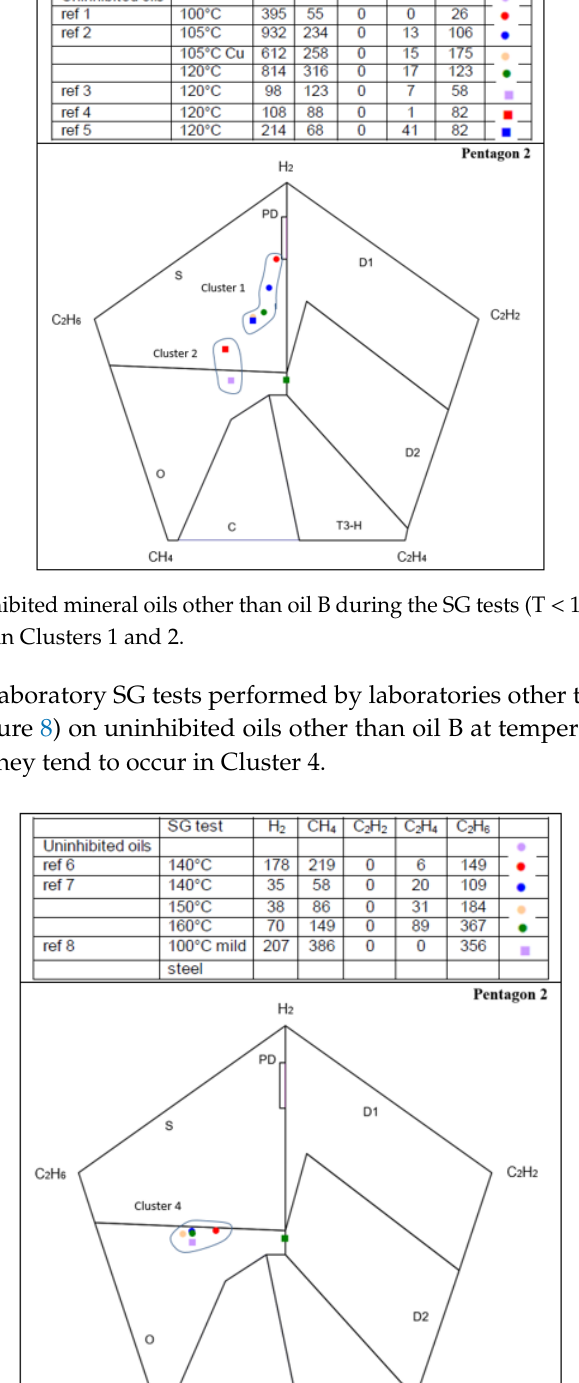
Figure 8. SG of uninhibited mineral oils other than oil B during the SG tests (T > 140 °C) by laboratories other than the FKH, in Cluster 4.